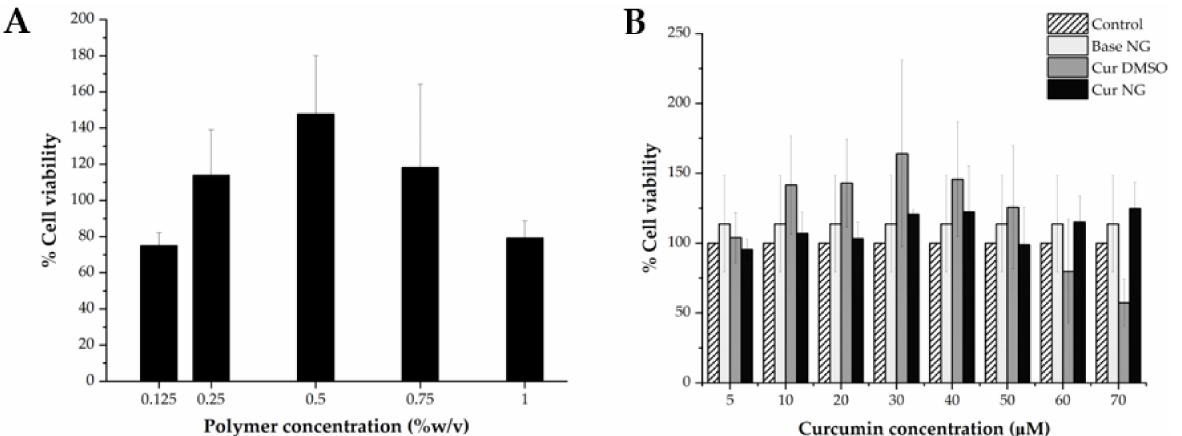
Figure 7. % cell viability of L929 cells after being treated by bare PNCDHA nanogel in different polymer concentrations ( A ) and cur-loaded PNCDHA nanogel with various curcumin concentrations ( B ) for 24